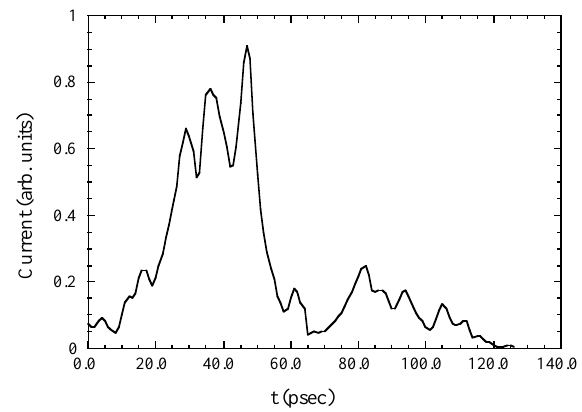
FIG. 5. Observation of the high-energy tail at spectrometer. In the legend, “wit.” indicates witness beam and “pl.” indicates plasma